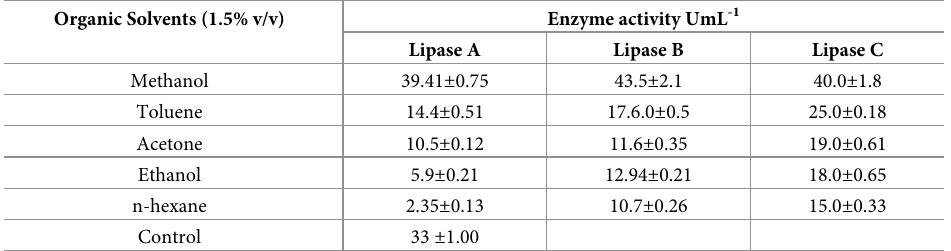
Table 7. Effect of organic solvents on the activity of lipase purified from B . cereus NC7401 cultured using starch (Lipase A), maltose (Lipase B), and tryptone (Lipase